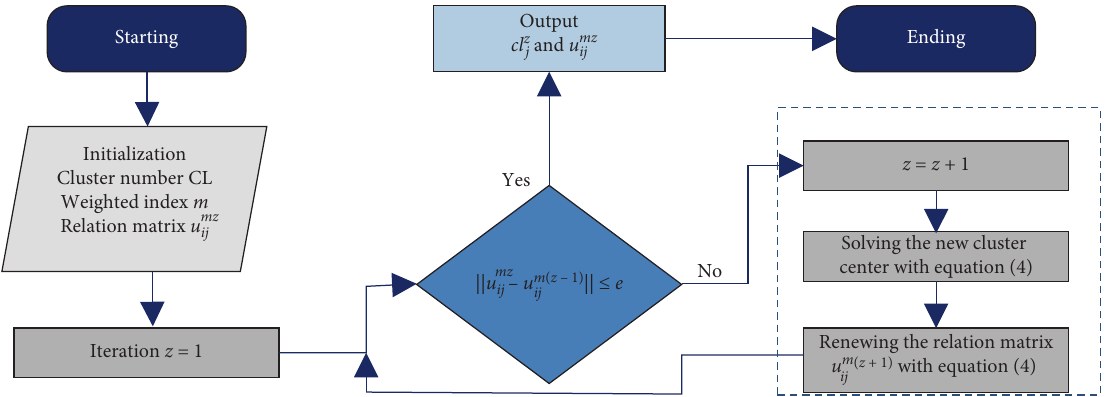
Figure 2: The framework of FCM clustering algorithm. Table 1: Evaluation indexes of pavement